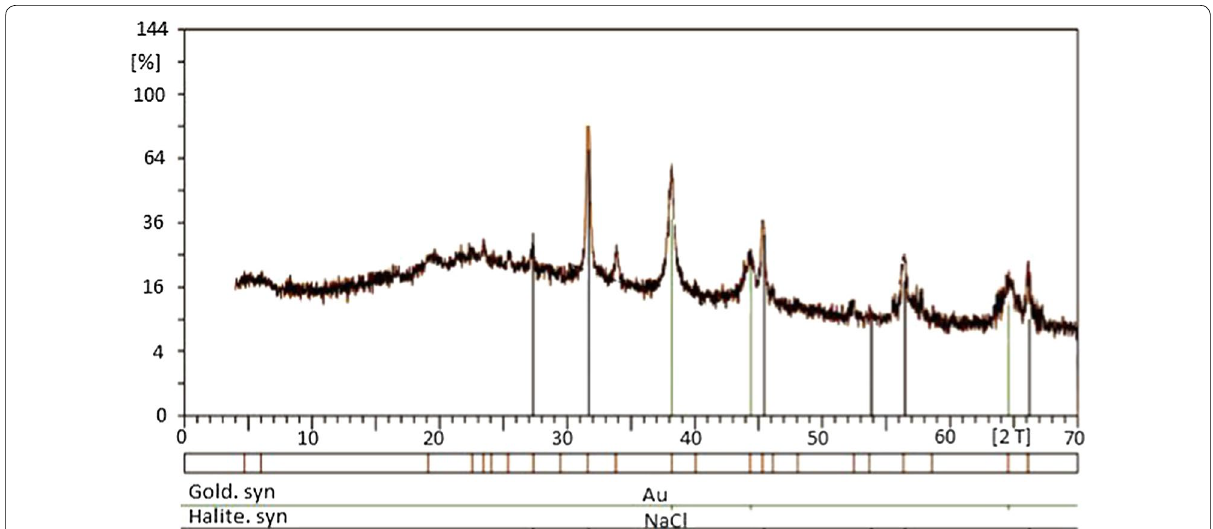
Fig. 4 XRD results of the fungal culture supernatant after GNPs production. The presence of impurities in the fungal culture led to the formation of additional peaks